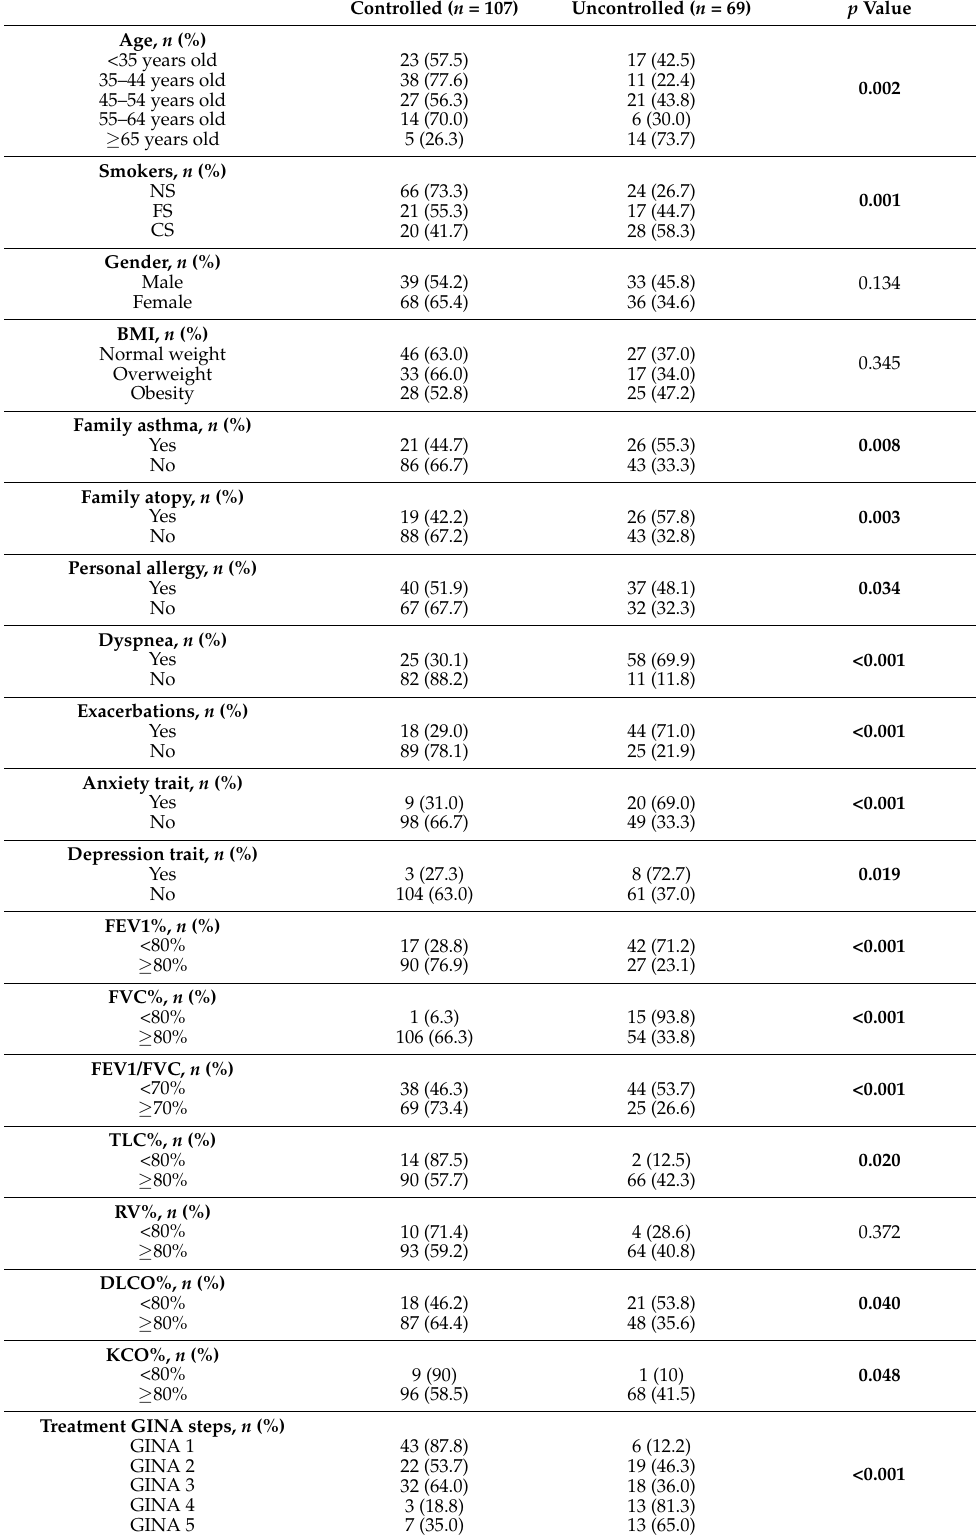
Table 3. Variables related to asthma control identified by univariate